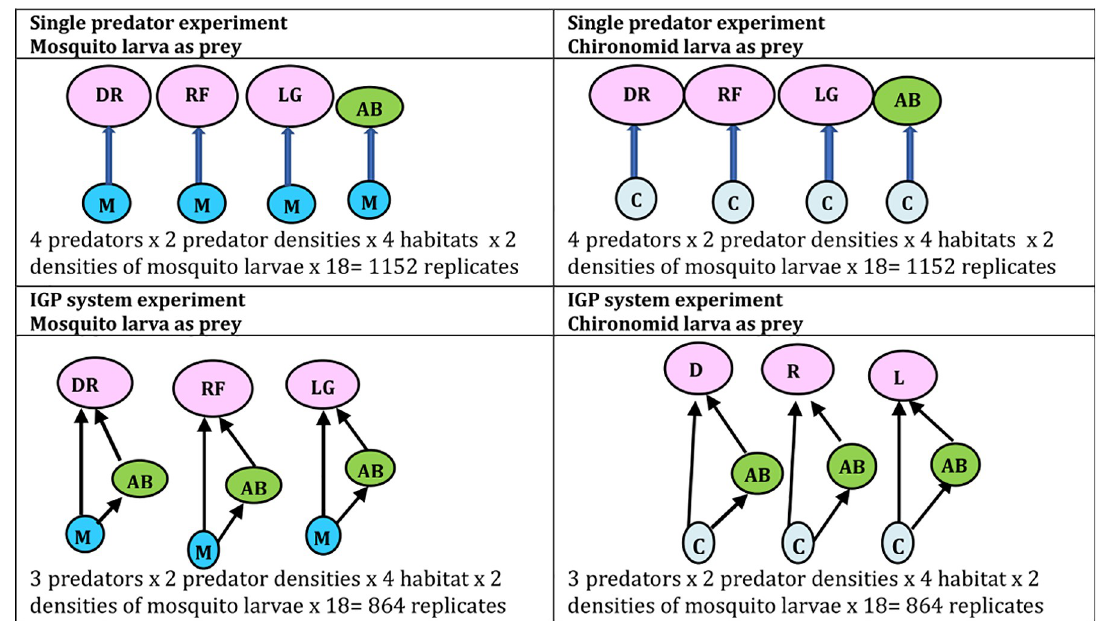
Fig 1. The portrayal of the interactions among the insect predator and prey involving the intraguild predation (IGP) system. As a shared prey both chironomid and mosquito larvae (Diptera) are consumed by the insect predators (Heteroptera) individually, as well as a part of the IGP system. Initial observations on single prey predator experiments were followed by the intraguild predation experiments under the varied habitat conditions represented in below.